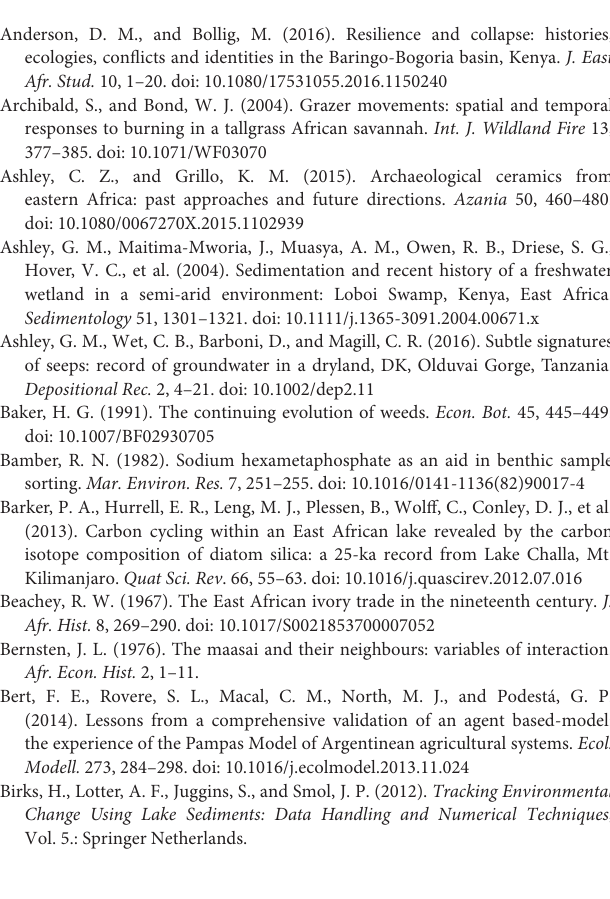
Table S2 | Table containing a list of all the pollen identified from the four Amboseli records, i.e., Enkongu, Kimana, Esambu and Namelok. The taxa identified, family and Plant Function Type are listed. Pioneer and disturbance taxa are highlighted. X means present N means absent. Classification into groups is based on